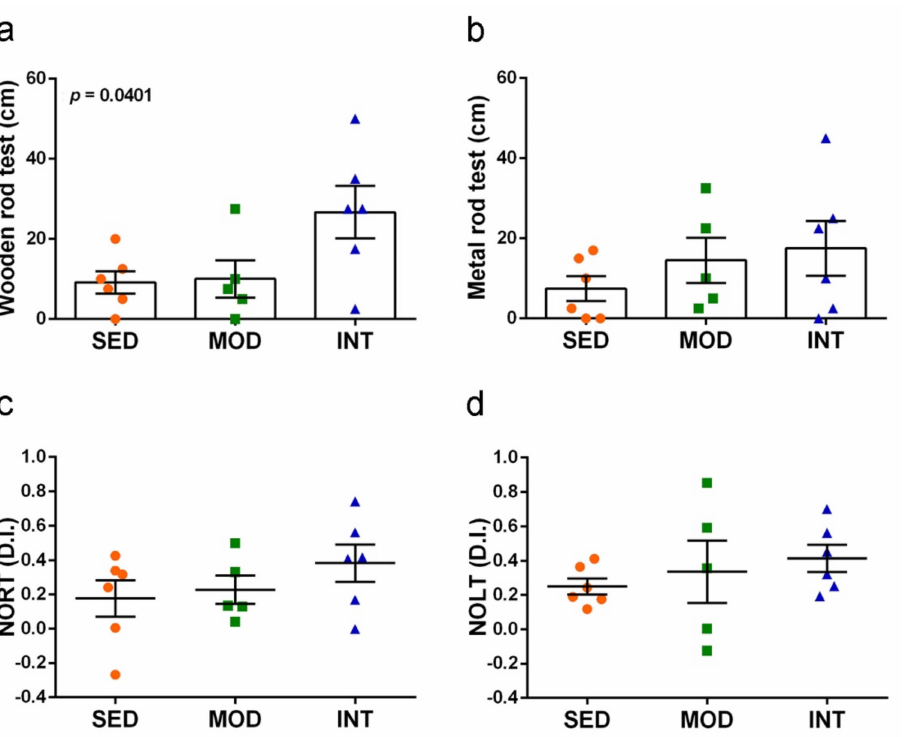
Figure 5. Exercise training improved motor coordination and maintained learning and memory skills. ( a ) Distance traveled on a squared wooden rod; ( b ) distance traveled on a round metal rod; ( c ) discrimination index (D.I.) in the novel object recognition test (NORT); ( d ) discrimination index (D.I.) in the novel object location test (NOLT). Experimental groups: SED (orange circles), sedentary; MOD (green squares), moderate training; INT (blue triangles), high-intensity training. Values are mean ± SEM (( a – d ) SED n = 6, MOD n = 5, INT n = 6). Statistics: There was a significant ANOVA effect of exercise treatment in ( a ) without post hoc test